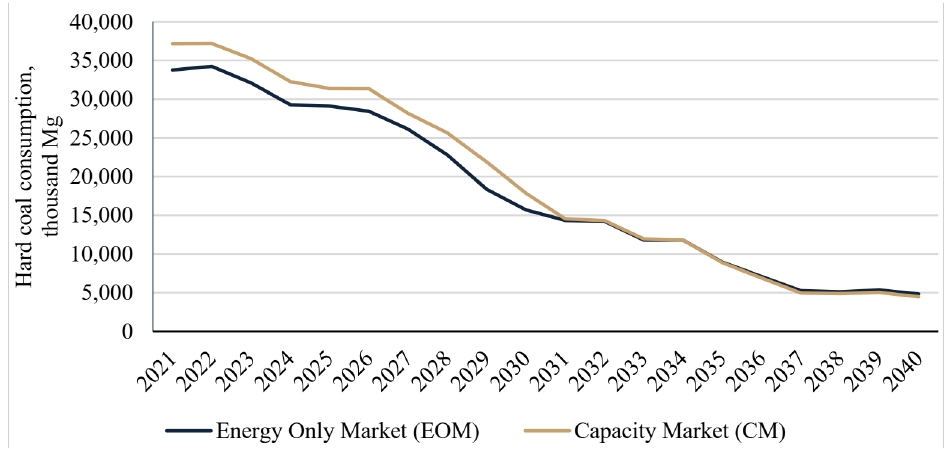
Figure 15. Hard coal consumption for electricity generation under the EOM and CM scenarios in 2021–2040.